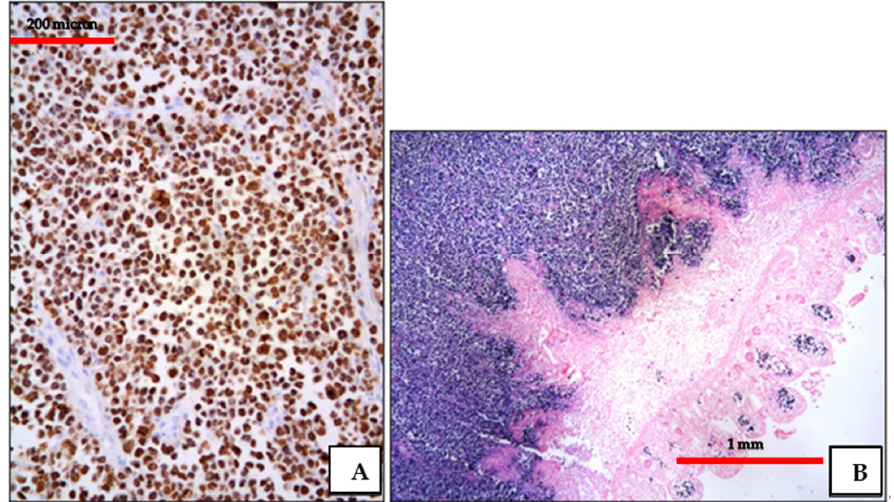
Figure 8. ( A ) EC-PEL of the ileum: strong and diffuse HHV8 positivity of the neoplastic cells; HHV8 expression is a diagnostic feature for EC-PEL (immunostaining, Ventana immunostainer, magnification 200 × ; original image from Prof Ascani); ( B ) EC-PEL of the ileum: diffuse EBV positivity of the neoplastic proliferation (EBER-ISH, magnification 40 × ; original image from Prof Ascani). HHV8 can also be documented by in situ hybridization or polymerase chain reaction (PCR) analyses. uals, PEL may be EBV-negative. Despite positivity for EBV by EBER, EBV-latent membrane protein 1 (LMP1) is usually absent, showing a type I latency pattern, similar to PBL. Clonal immunoglobulin (IG) gene rearrangement is present, indicating a B-cell origin. In some cases, T-cell receptor (TCR) gene rearrangement may be found in addition to IG genes. HHV8 viral genomes are present in all cases. Rearrangements at the MYC , BCL2 and BCL6 loci are usually absent. Structural alterations in the MYC gene are absent; however, MYC protein overexpression may be seen, probably due to the activity of HHV8-encoded latent proteins [58] (Figure 9).